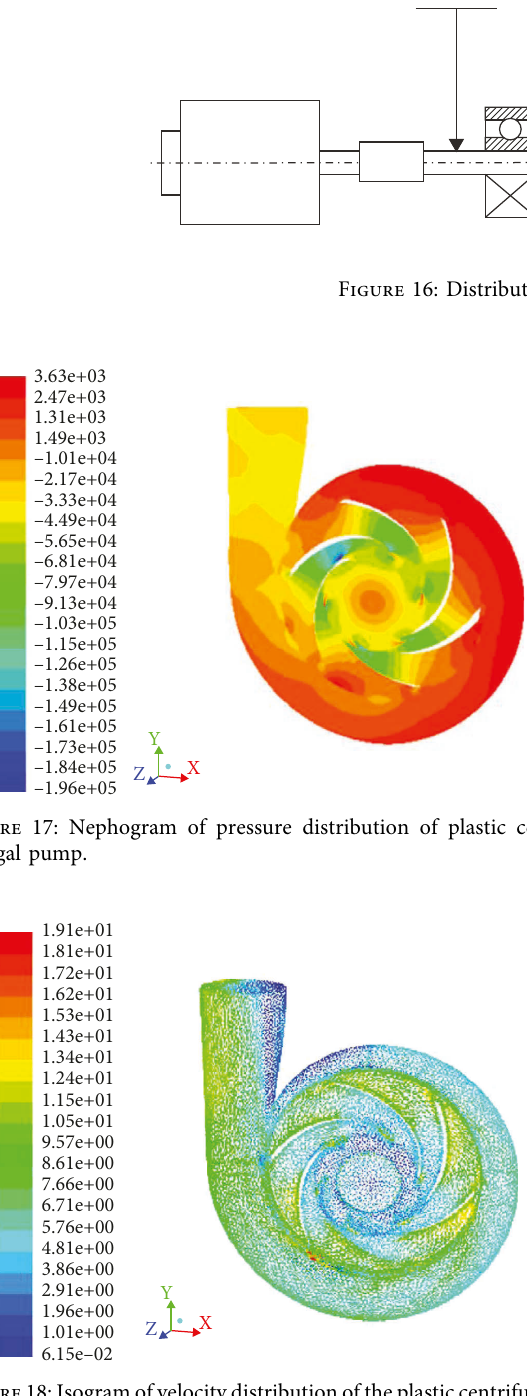
Figure 18: Isogram of velocity distribution of the plastic centrifugal pump.